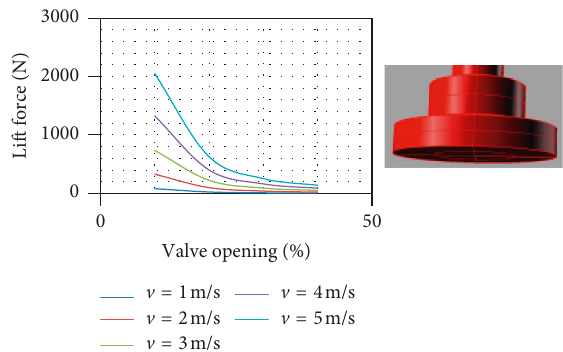
Figure 14: Relation between lift force and valve opening at different inlet velocity for flat face plug.